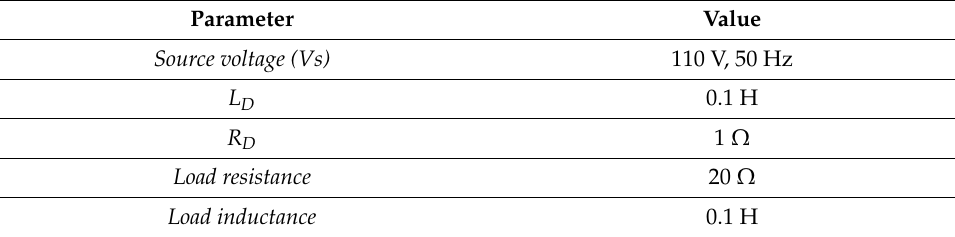
Figure 9. Laboratory test set-up. Table 2. Experimental setup